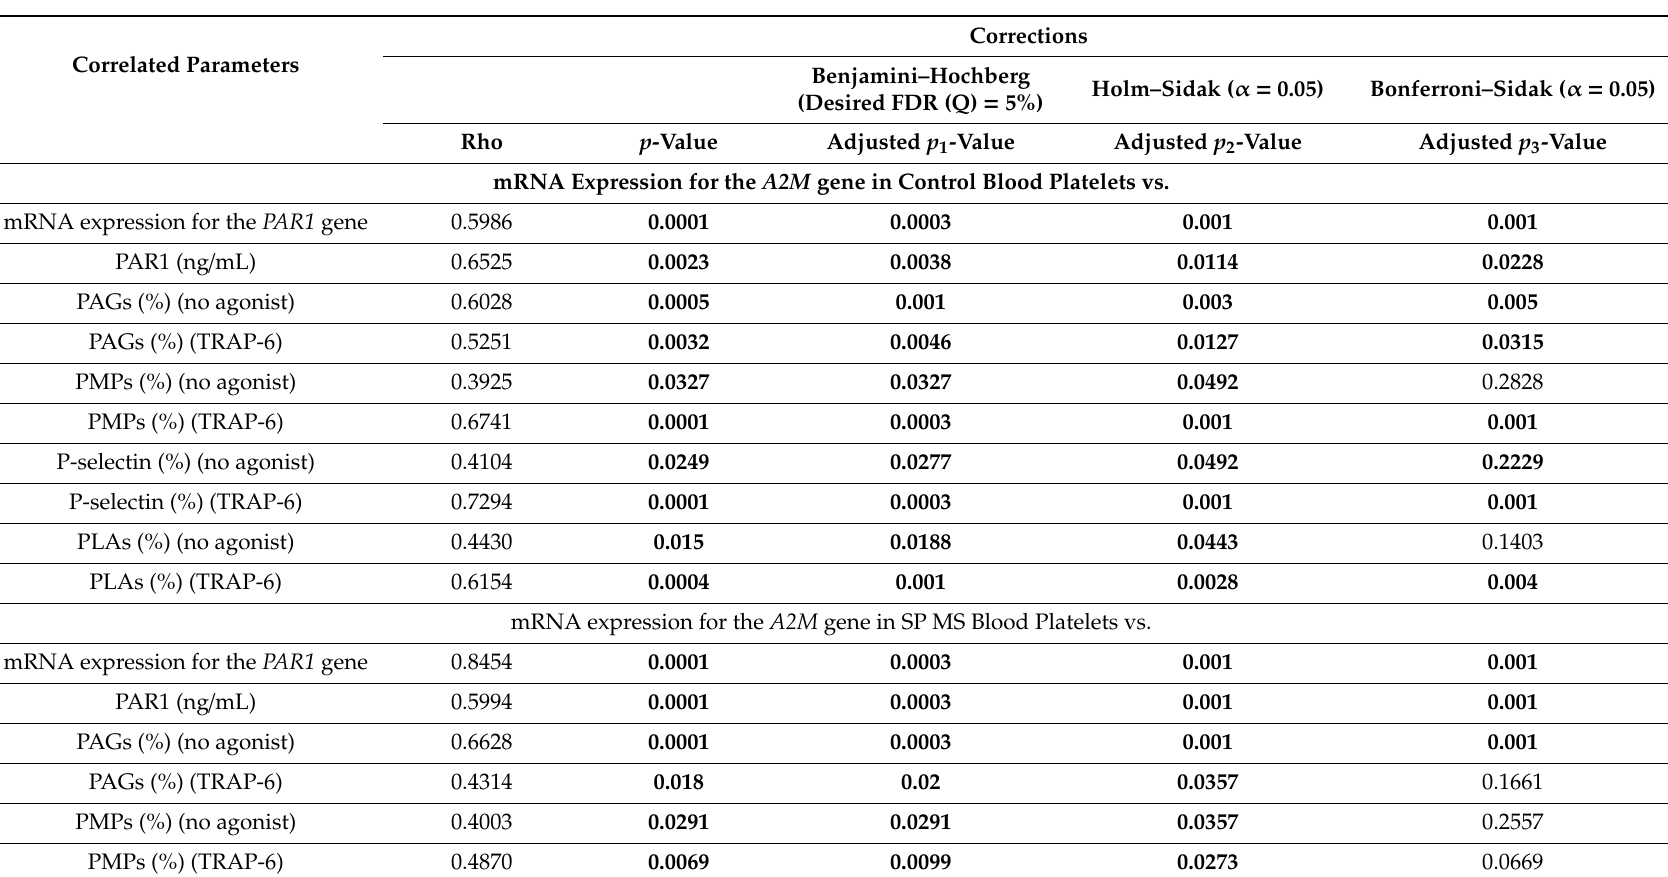
Table 1. Correlation coe ffi cient value obtained for expression of atherosclerosis biomarkers ( A2M and APOA1 ) and PAR1 expression and level of platelet activity markers (PAGs, PMPs, P-selectin and PLAs). The correlation was analyzed using Spearman’s rank correlation (Rho) method. The table consists of Rho, probability of correlation ( p ) and adjusted p -values for multiple tests by Benjamini–Hochberg, Holm–Sidak and Bonferroni–Sidak methods. Corrected p -values below 0.05 are considered as statistically significant and highlighted in